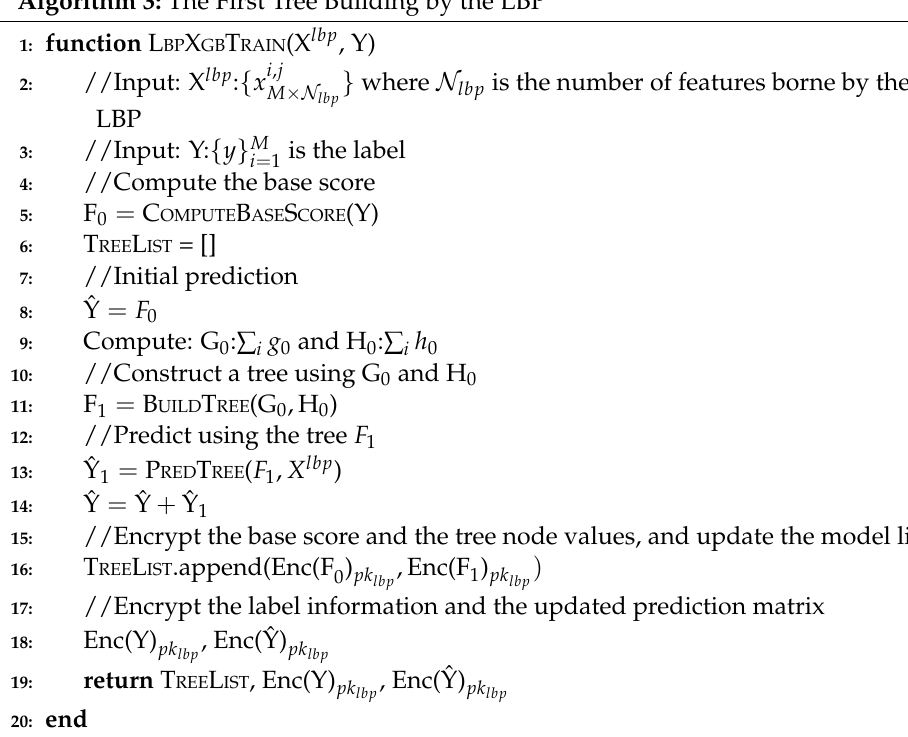
Algorithm 3: The First Tree Building by the